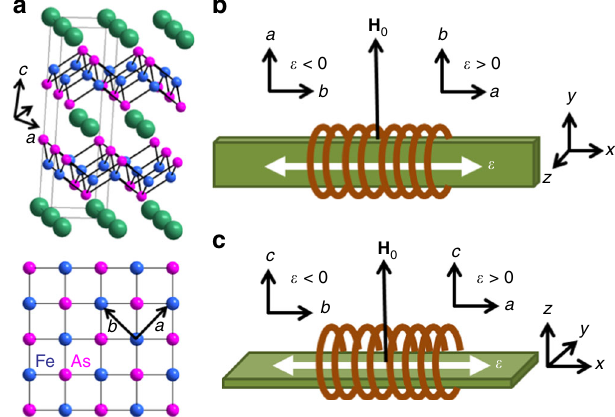
Fig. 1 Application of uniaxial strain. a Crystal structure of BaFe 2 As 2 , with Ba (green), Fe (blue) and As (magenta) sites shown. Lower panel shows the Fe – As plane in the tetragonal phase, with arrows indicating the unit cell axes of the orthorhombic phase ð a k ð 110 Þ of the magnetic fi eld with respect to the coil ( H 1 ) and strain axis for H 0 ⊥ c ( b ) and H 0 ∥ c ( c ). For positive (tensile) strain H 0 is parallel to ( b ), whereas for negative (compressive) strain H 0 is along ( a